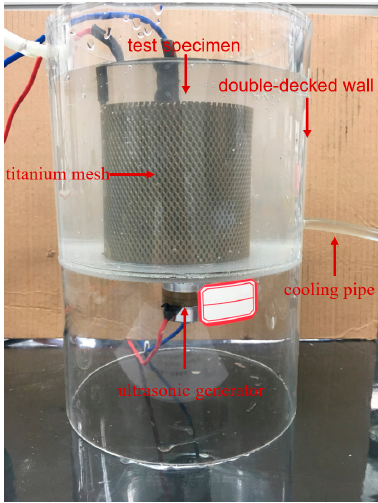
Figure 2. Ultrasound-assisted electrochemical chloride removal (ECR)